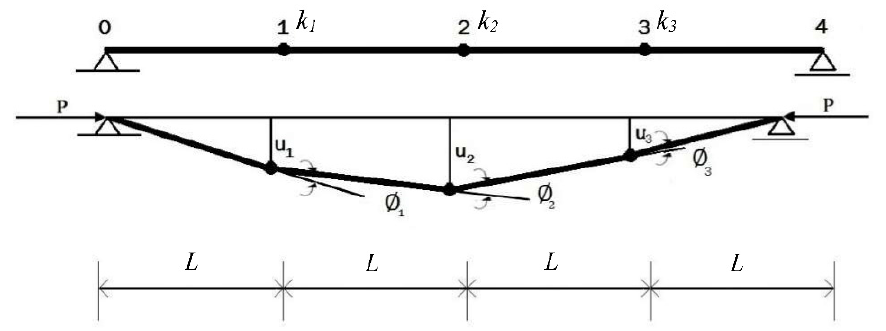
Figure 1. Proposed model of the structure.